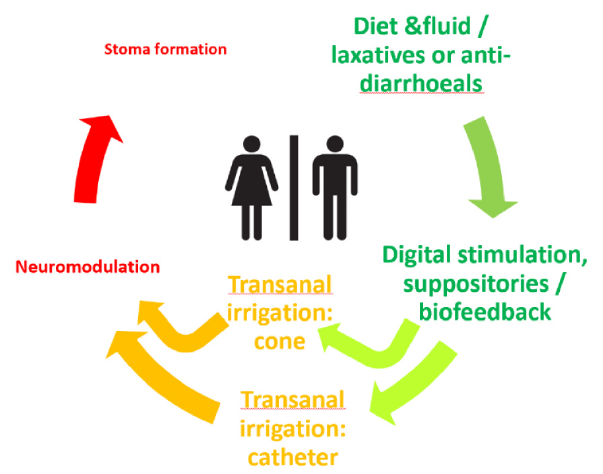
Figure 1. Care options for the management of neurogenic bowel dysfunction. Font size reflects the frequency of the options being used. Color gradation: green = conservative, orange = minimally invasive, red = invasive 15